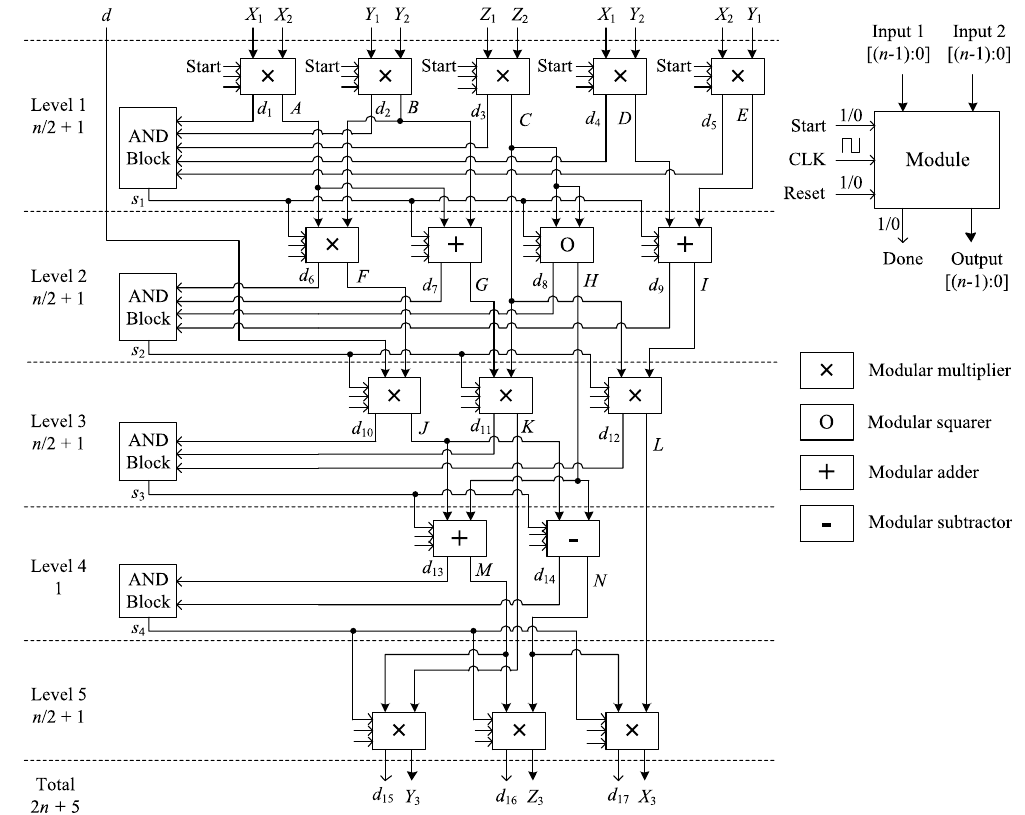
Figure 4. Proposed hardware architecture for unified